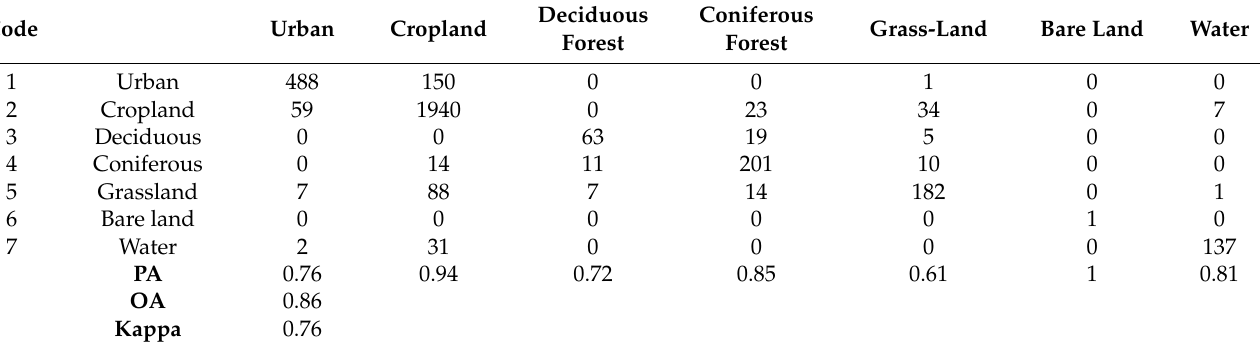
Table A1. Accuracy assessment of land cover classes in six cities (OA: overall accuracy; PA: producer’s accuracy).